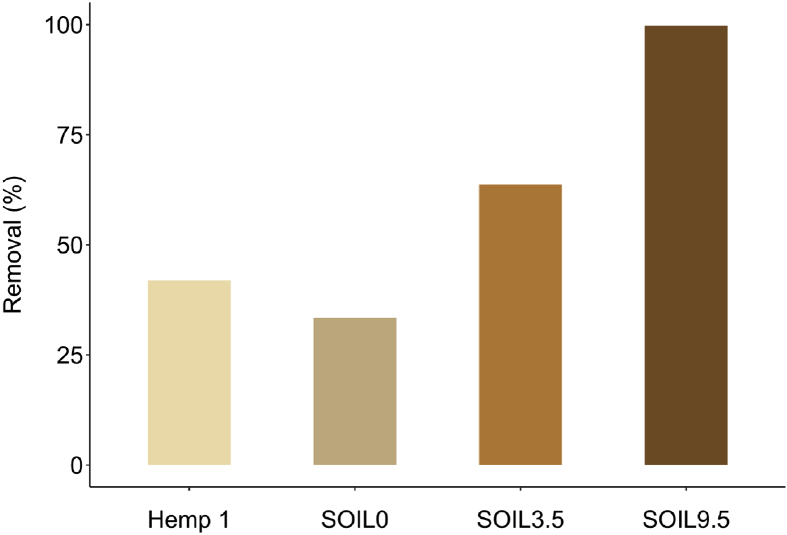
Comparison of difenoconazole removal (in %) using hemp and three soils at a fixed difenoconazole concentration of 12 mg/L: Hemp 1 (mass: 0.35g), SOIL0 = Fontainebleau® sand, SOIL3.5 and SOIL9.5 = soils with 3.5% and 9.5% of organic matter, respectively (conditions: percolation experiments; number of passes = 1; temperature = 25 °C; n = 3).